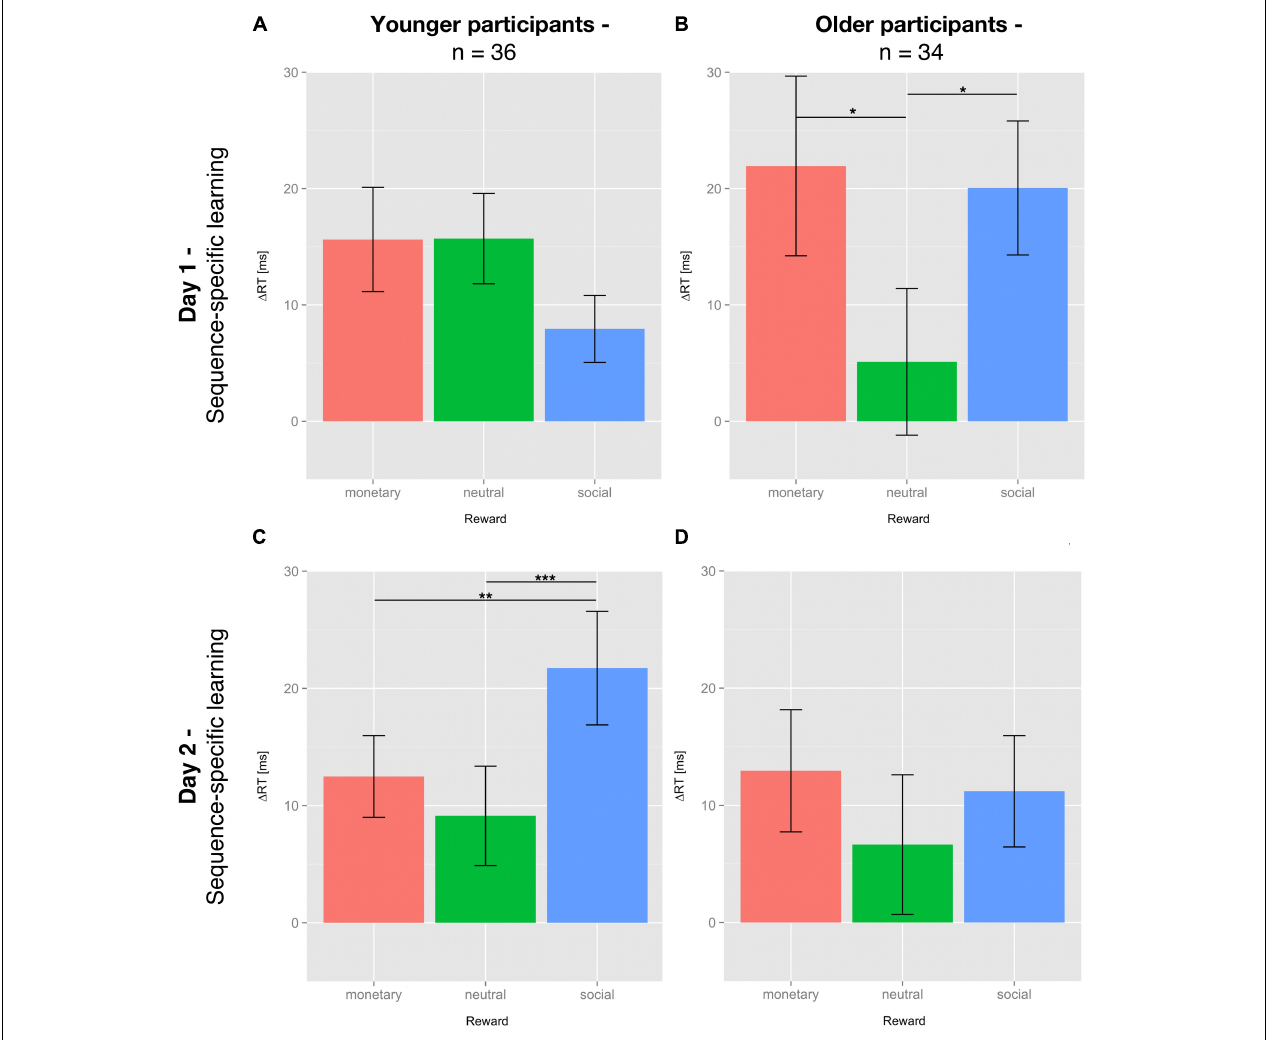
FIGURE 3 | Sequence-specific learning effects of young and older subjects on day 1 and 2. Sequence-specific learning (SSL) effects are calculated by subtracting the mean of the median reaction time (RT) of sequence blocks s5 and s7 from the median RT of the random block r6 (day 1) or subtracting the median RT of the respective sequence block from the mean of the median RT of all random blocks (day 2). SSL effects are depicted for day 1 (A,B) and day 2 (C,D) , young (A,C) and older (B,D) participants and all three feedback conditions: neutral feedback (green), social reward (blue), and monetary reward (red). Displayed are the means ± SEM. The asterisks denote significant differences between rewards: ∗ p < 0.05; ∗∗ p < 0.01; ∗∗∗ p <